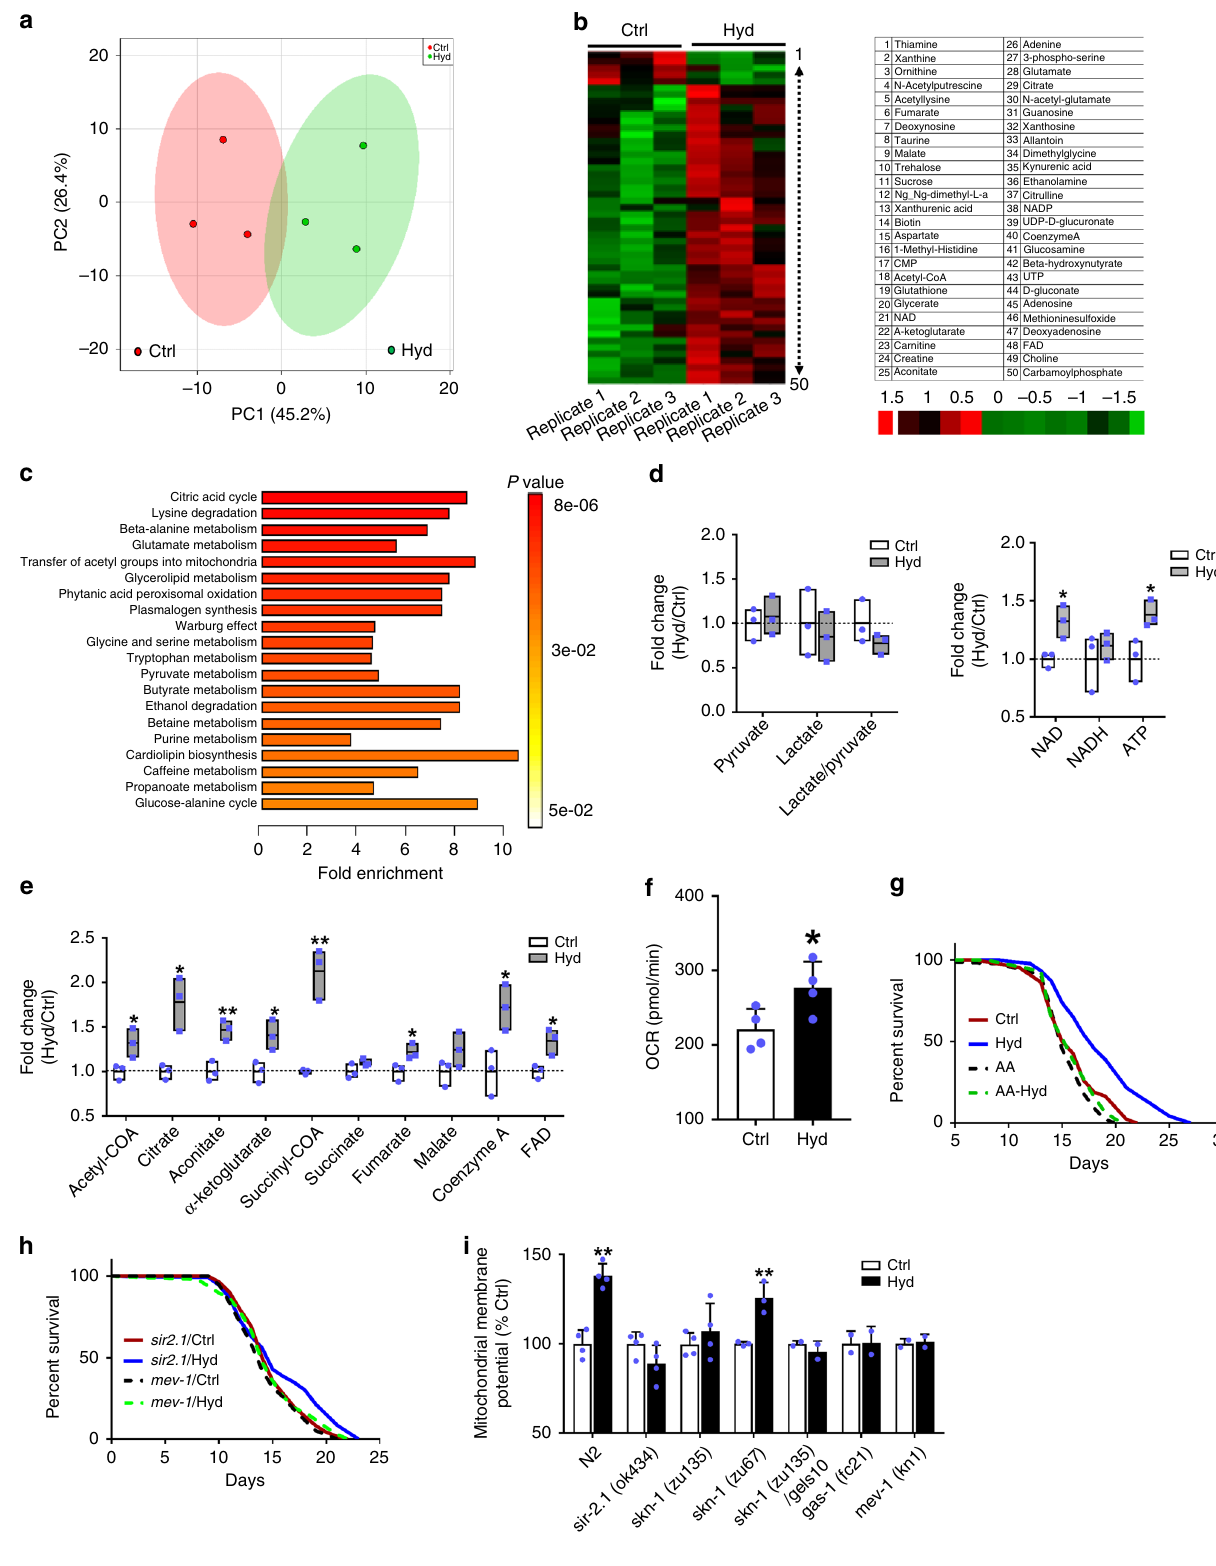
demonstrating hydralazine ’ s protective effect against glucose- induced mitochondrial fragmentation (Fig. 4e). These data demonstrated the detrimental effect of high glucose diet on C. elegans mitochondrial metabolism and the ability of hydralazine to effectively reverse the negative impact of high glucose.